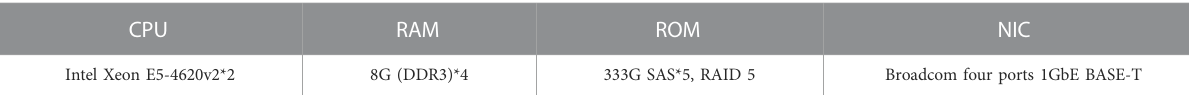
FIGURE 4 Data coupling fl ow diagram.